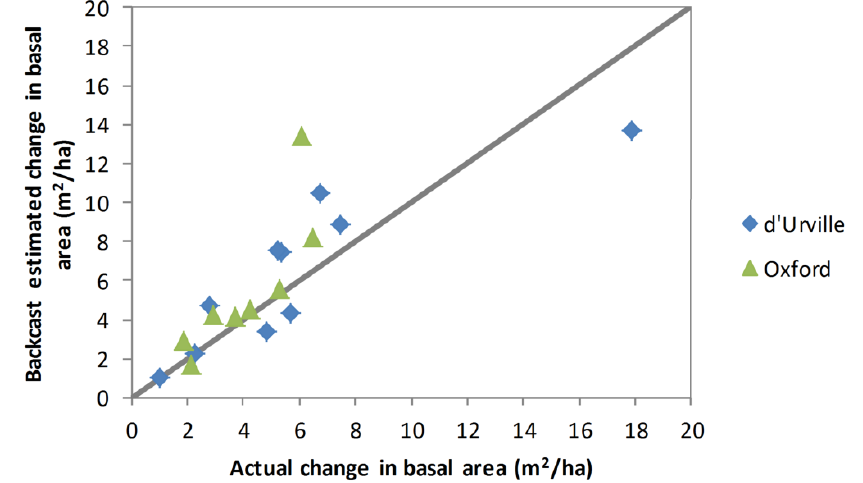
Figure 5. Backcast estimated 2008–2012 change in basal area versus actual change in basal area for plants measured for diameter and height in both 2008 and 2012. Values shown are plot means. The line indicates the y = x